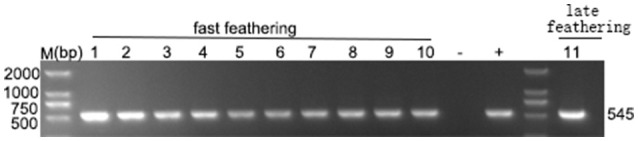
Detection of ALV-J specific elements. ELISA positive samples were selected to detect the ALV-J specific 545 bp fragment. Lanes 1–10, fast feathering chicken samples. Lane 11, late feathering chicken sample. All the ELISA positive samples produced specific 545 bp fragment. (−) negative control (purified water), (+) positive control (DNA extracted from the DF-1 cells infected with ALV-J strain SCAU-HN06, Lai et al., 2011).